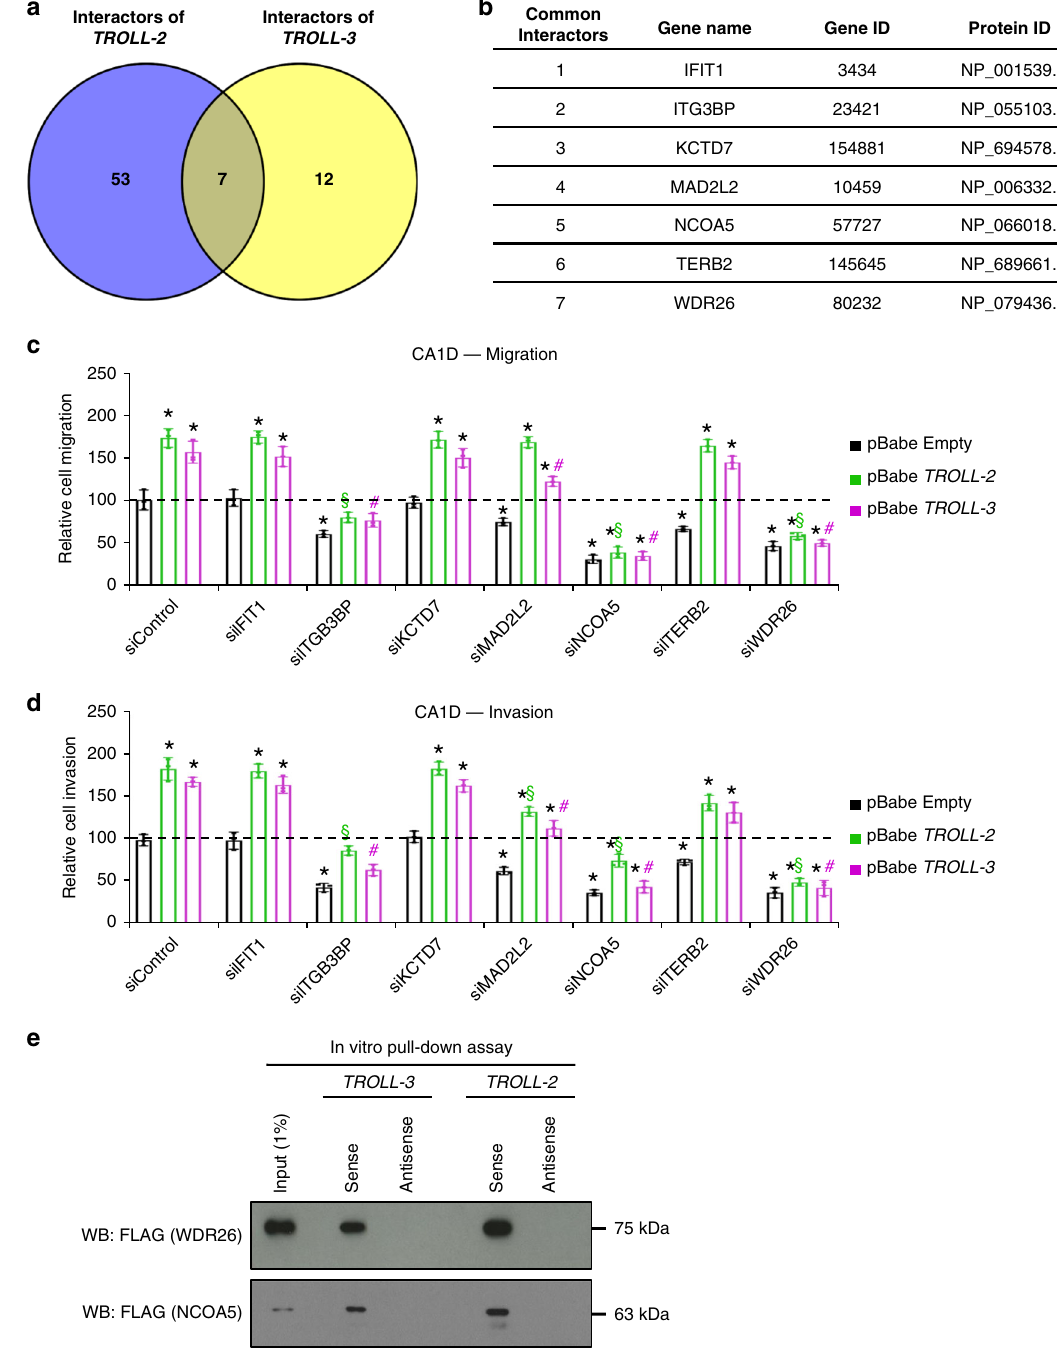
Fig. 3 TROLL-2 and TROLL-3 promote cancer progression via WDR26. a Venn diagram of the proteins interacting with TROLL-2 and TROLL-3 . b Table listing the 7 common interactors of TROLL-2 and TROLL-3 . c , d Quanti fi cation of cell migration ( c ) and invasion ( d ) of CA1D cells overexpressing either TROLL-2 , TROLL-3 , or the empty vector, and transfected with the indicated siRNAs. Graphs represent the individual data points, mean ± SD and analysed with two-tailed Student ’ s t test, n = 3 biological replicates, asterisk vs. pBabe Empty siControl, P < 0.005. Section vs. pBabe TROLL-2 siControl, P < 0.005. Hash vs. pBabe TROLL-3 siControl, P < 0.005. e Representative western blot for the indicated proteins pulled down by the indicated lncRNAs. n = 3 biological replicates. Source data are provided as Source data fi